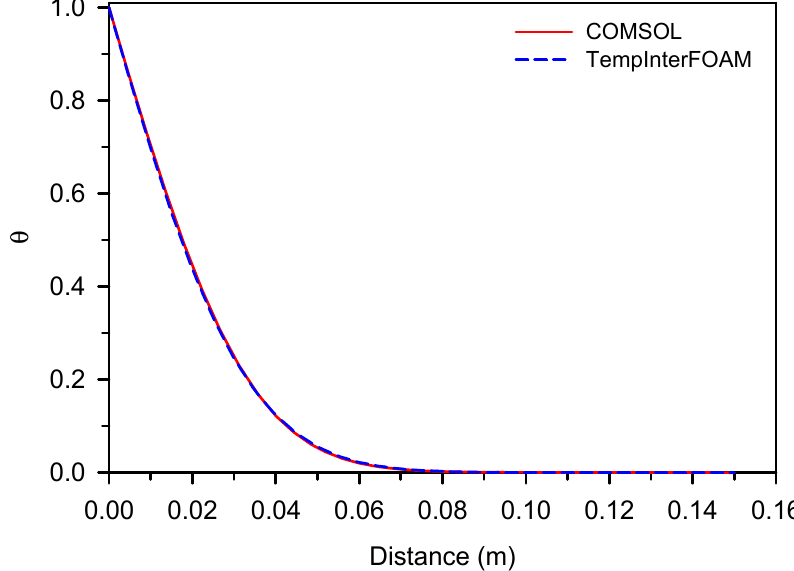
Figure A2. Dimensionless temperature profile along the axis (distance from the bottom wall) resulting from the calculations using OpenFOAM with our new module (TempInterFoam) as well as COMSOL Multiphysics.